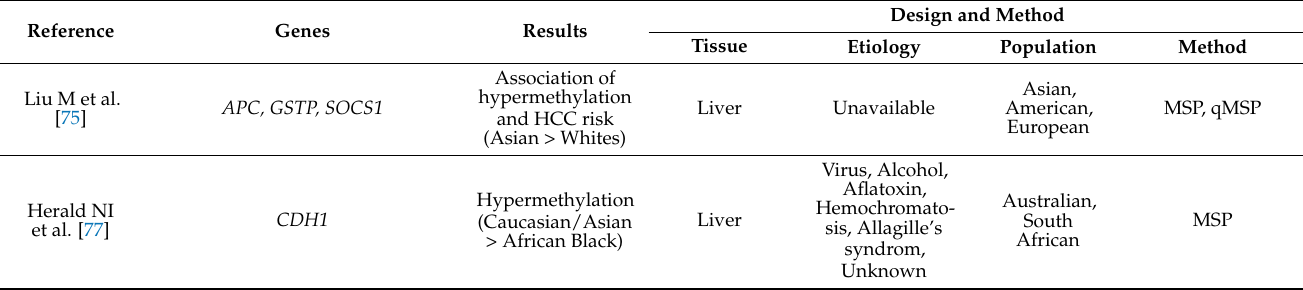
Table 3. Genes or genomic loci showing race/ethnicity-related differential methylation in